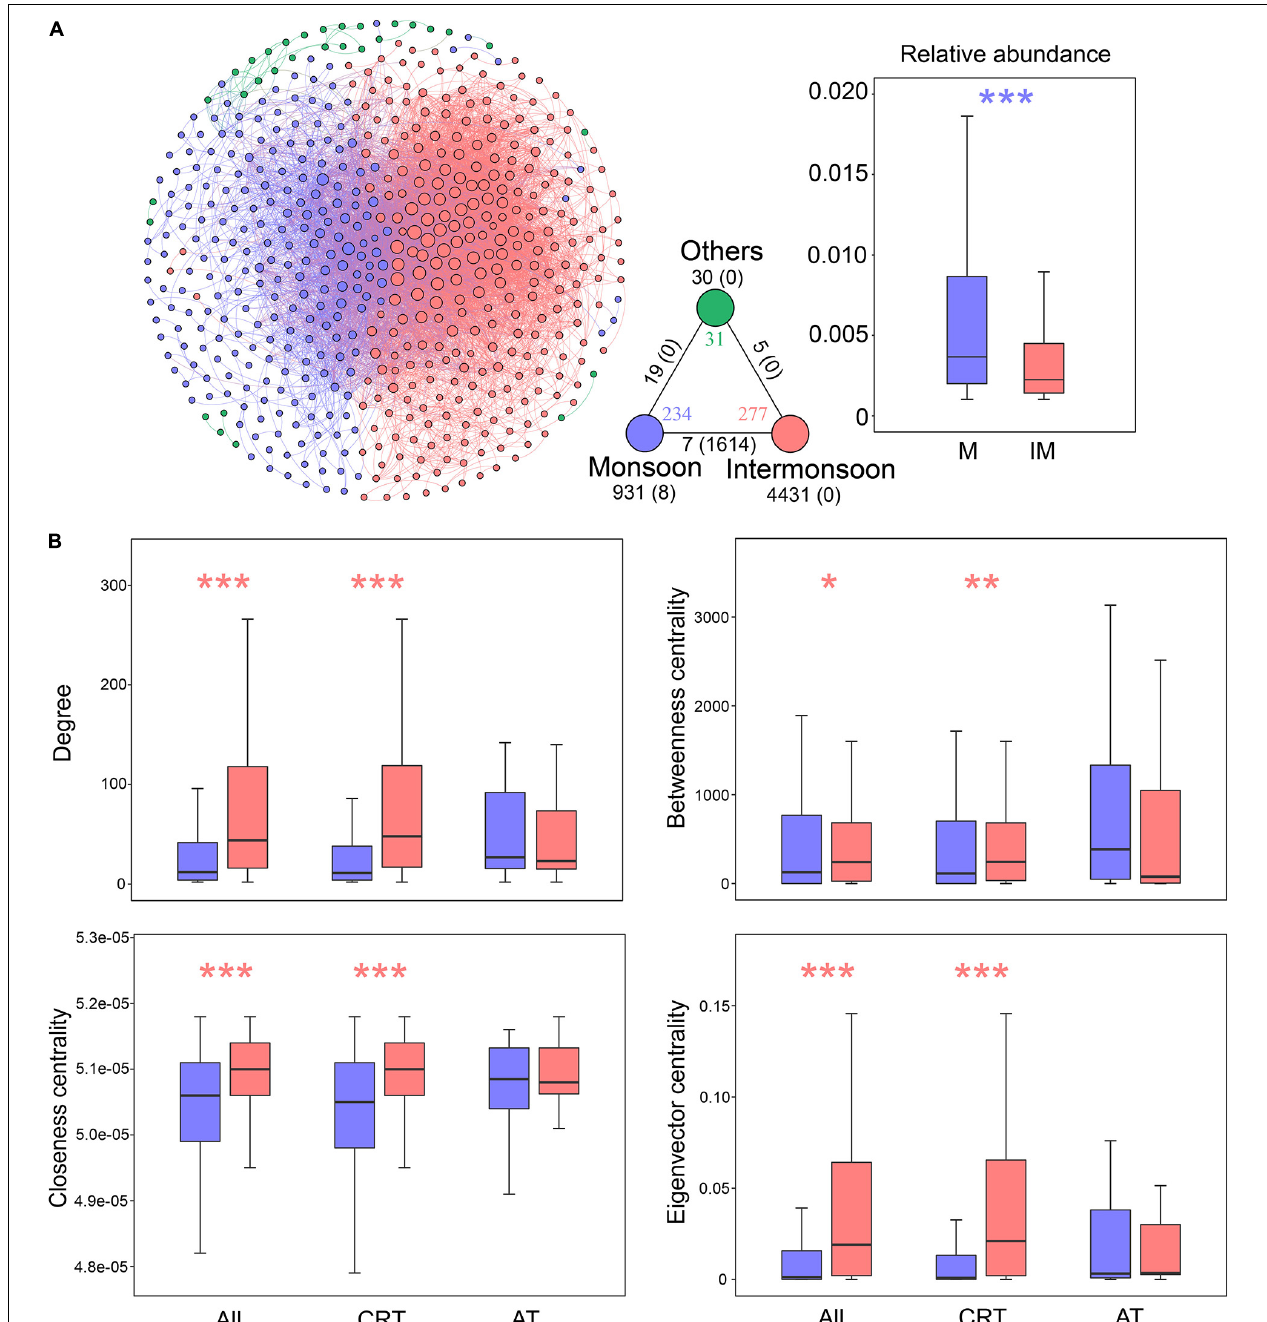
FIGURE 3 | Properties of the co-occurrence network in bacterial communities during the monsoon and intermonsoon periods. (A) The network was conducted by strong (Spearman’s | r | > 0.8) and significant ( p -value < 0.01) correlations between OTUs in the metacommunity. Each node represents an OTU, and each edge represents a correlation. The size of nodes is proportional to the degree of corresponding OTUs (the number of connections). The networks were colored based on monsoon or intermonsoon enriched OTUs, showing the intra-associations within each season and inter-associations between the two seasons. The triangle located at the bottom right of the network figure is a summary of the intra-associations and inter-associations. Colored numbers indicate the number of nodes belonging to the corresponding category (i.e., there were 234 nodes in the “monsoon” category). Numbers outside and inside parentheses, respectively, indicate the numbers of positive edges and negative edges. Black numbers near the apex of the triangle in turn indicate the number of intra-associations. Numbers near the triangle edge in turn indicate the number of cross-group interactions. The boxplot showing the relative abundance of seasonal enriched OTUs. (B) Seasonal comparison of node-level topological features among metacommunity and subcommunities. Blue asterisks indicate the values significantly higher in monsoon-enriched taxa (* p < 0.05; ** p < 0.01; *** p < 0.001; Wilcoxon rank-sum test); red asterisks indicate the properties significantly higher in intermonsoon-enriched taxa. Monsoon, monsoon-enriched OTUs; Intermonsoon, intermonsoon-enriched OTUs; Others, OTUs not specific to a group. RT, rare taxa; AT, abundant taxa.